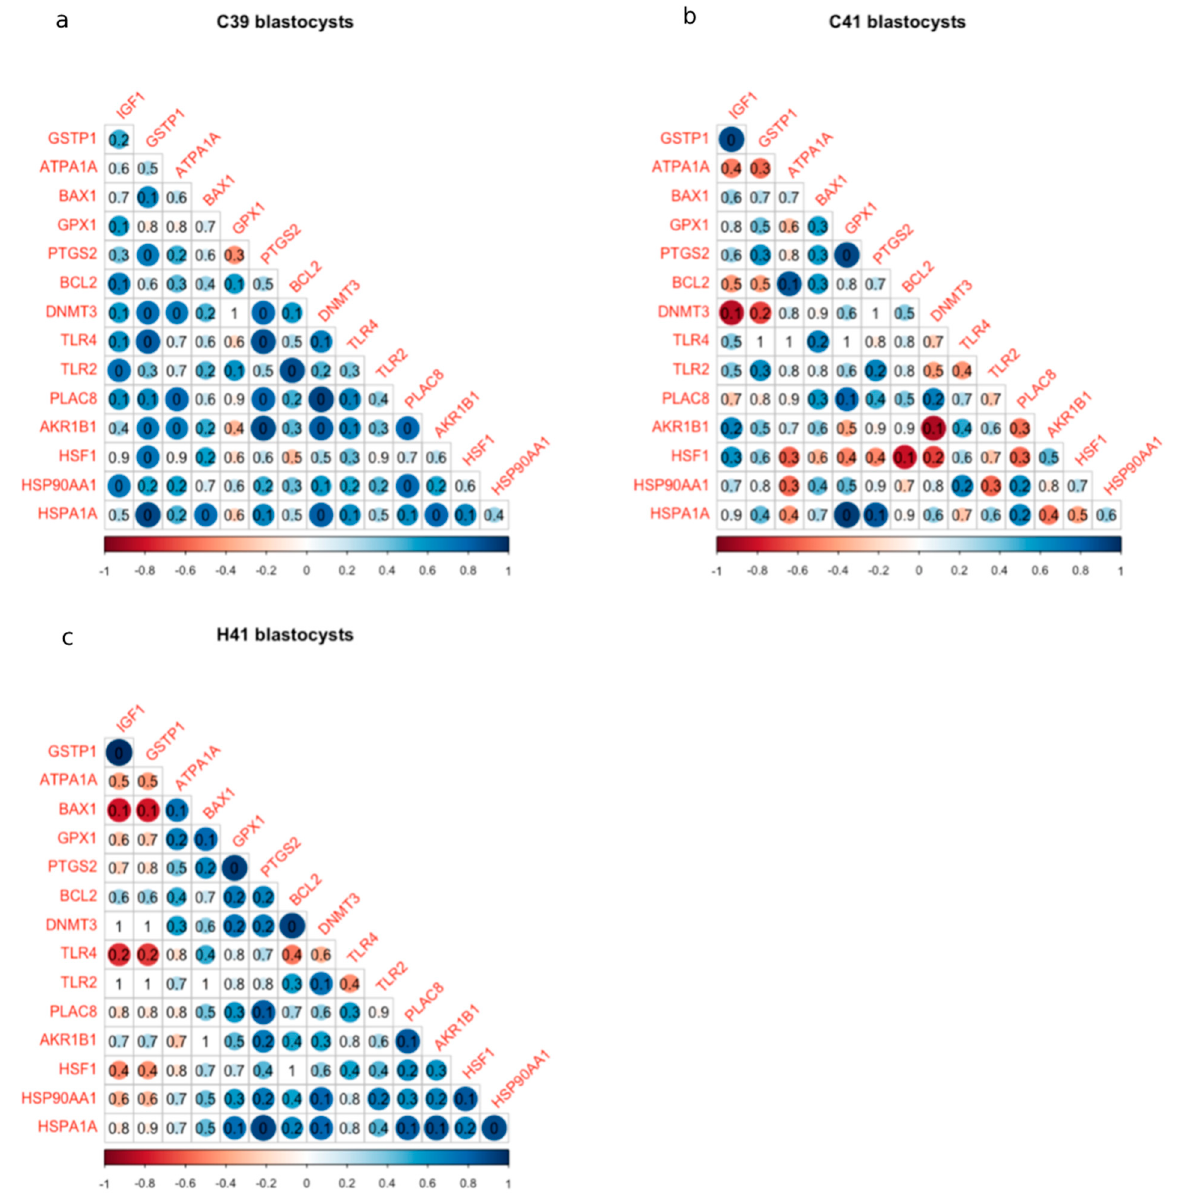
Figure 2. Pairwise correlation coefficients of genes in the groups under study: in blastocysts cultured at 39 °C group (C39, a ) or under raised temperature (41 °C) for 24 h in the absence (group C41, b ) or presence of HSP70 (group H41, c ) in the culture medium. Positive correlations are displayed in blue and negative correlations in red color. Color intensity and the size of the circle are proportional to the correlation coefficients. P -values of each correlation are presented in each circle.